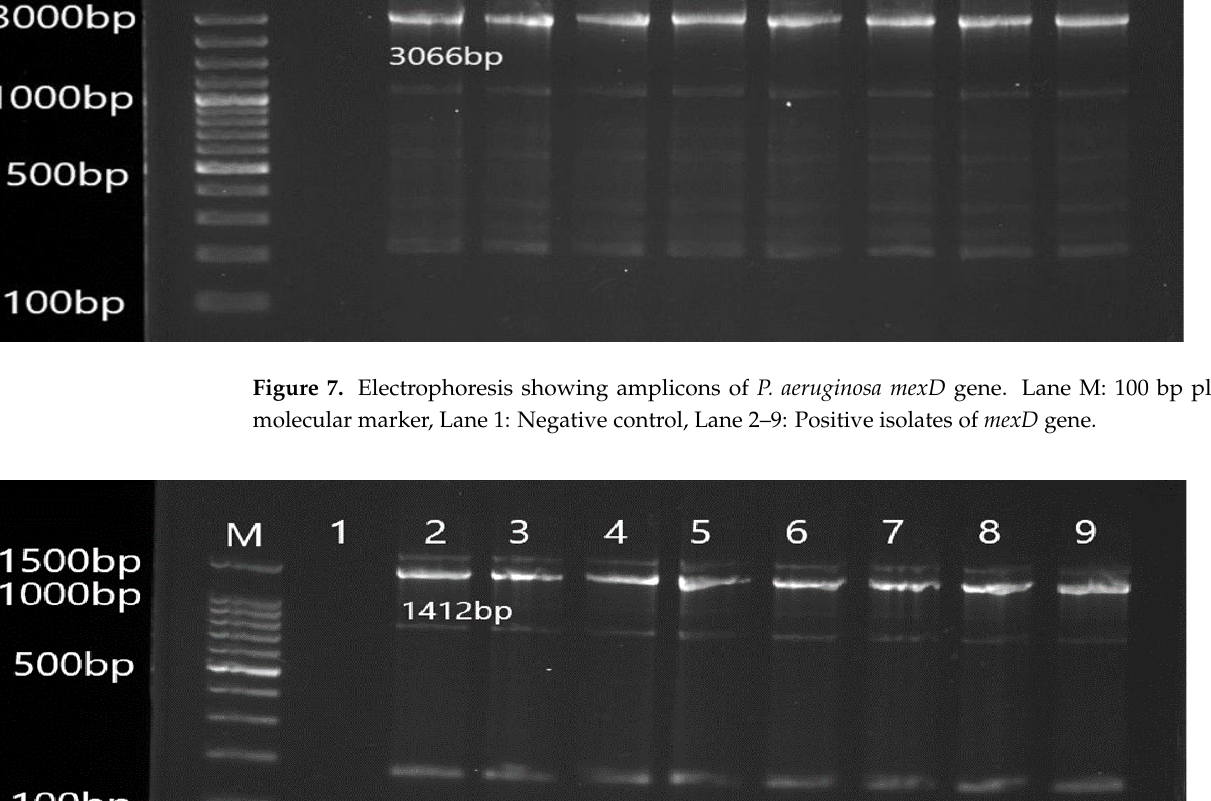
Figure 8. Electrophoresis showing amplicons of P. aeruginosa oprJ gene. Lane M: 100 bp molecular marker, Lane 1: Negative control, Lane 2–9: Positive isolates of oprJ gene.